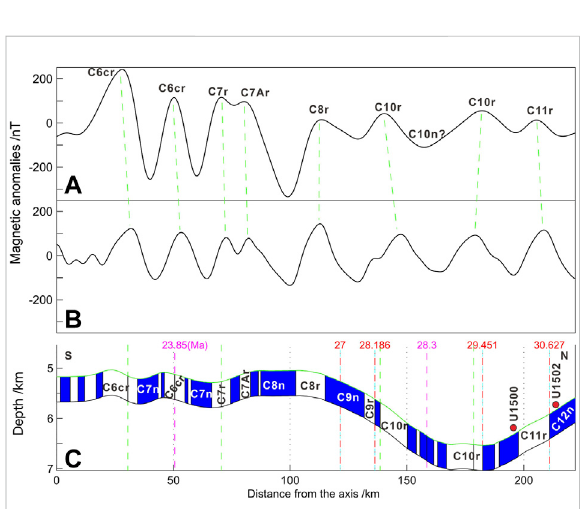
FIGURE 4 Magnetic anomalies on N4 pro fi le. (A) Magnetic anomalies and RTP Magnetic anomalies. The yellow and pink shades represent the negative and positive magnetic lineation areas respectively; (B) inverted basement magnetization. MQZ: magnetic quiet zone; OC: oceanic crust.